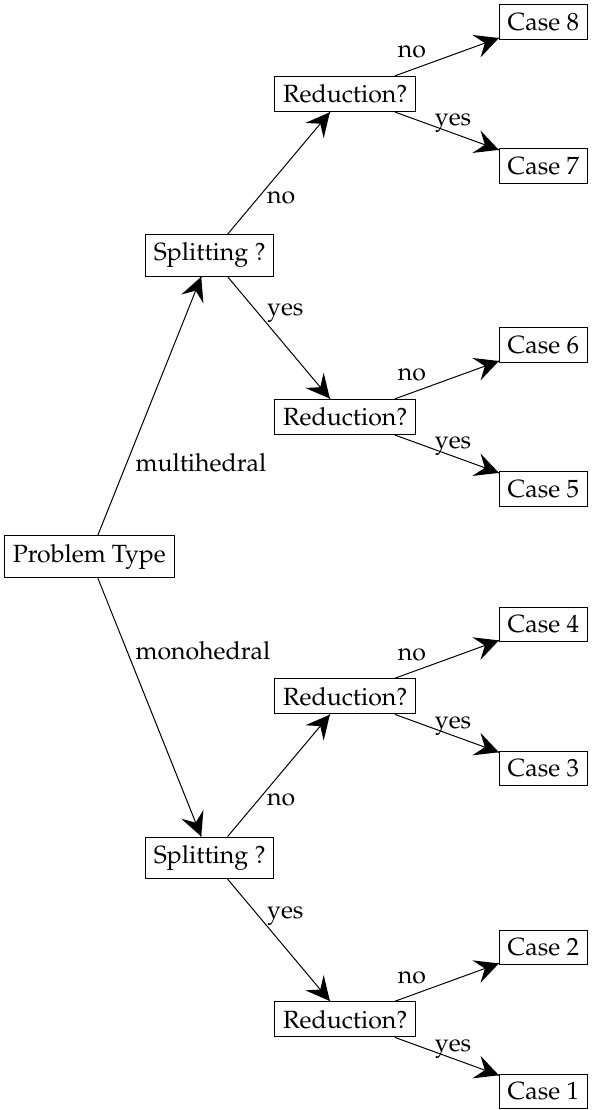
Figure 12. A decision tree for the following alternatives: monohedral polyomino tiling problem versus multihedral polyomino tiling problem; checkerboard colouring technique applied to a tiling problem splits the problem into multiple ( ≥ 2) tiling pariomino subproblems versus no splitting; checkerboard colouring technique applied to a tiling problem yields a reduction in complexity of the associated pariomino tiling subproblem(s) versus no reduction in